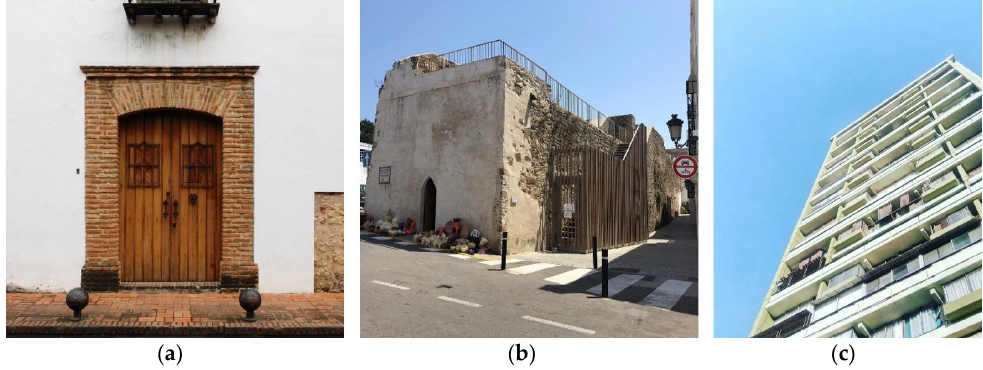
Figure 5. Architectural heritage pictures collected from #patrimonioarquitectonico in Instagram